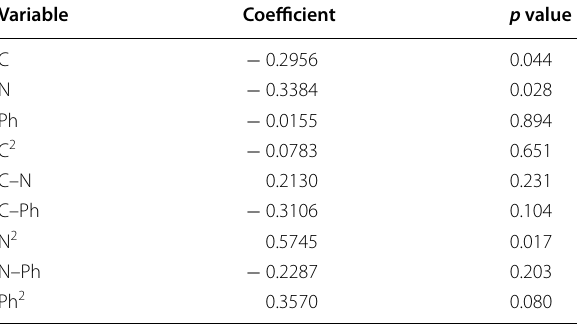
Table 5 Coefficient and p values for independent variables and their interactions, obtained from optimization of culture